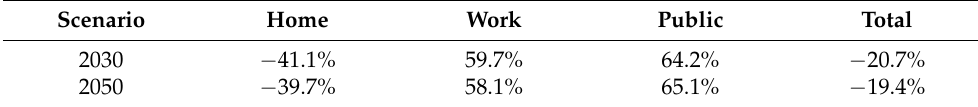
Figure 13. Correlation between the charging and distributed PV profiles in 2050. Table 4. Correlation between each charging profile and the distributed PV